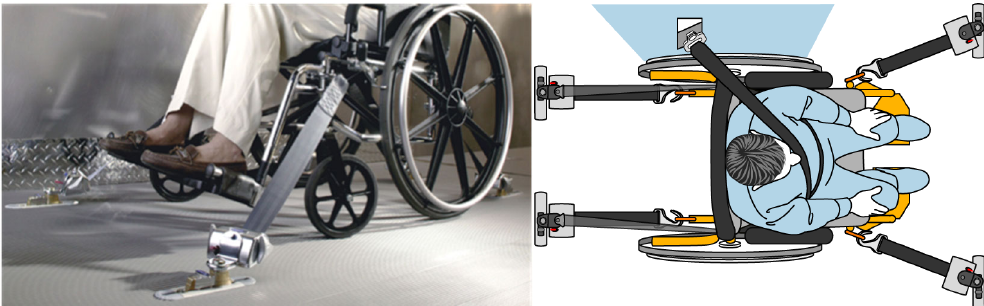
Figure 2. Example of a wheelchair secured by 4 ‐ pt strap tiedown system.